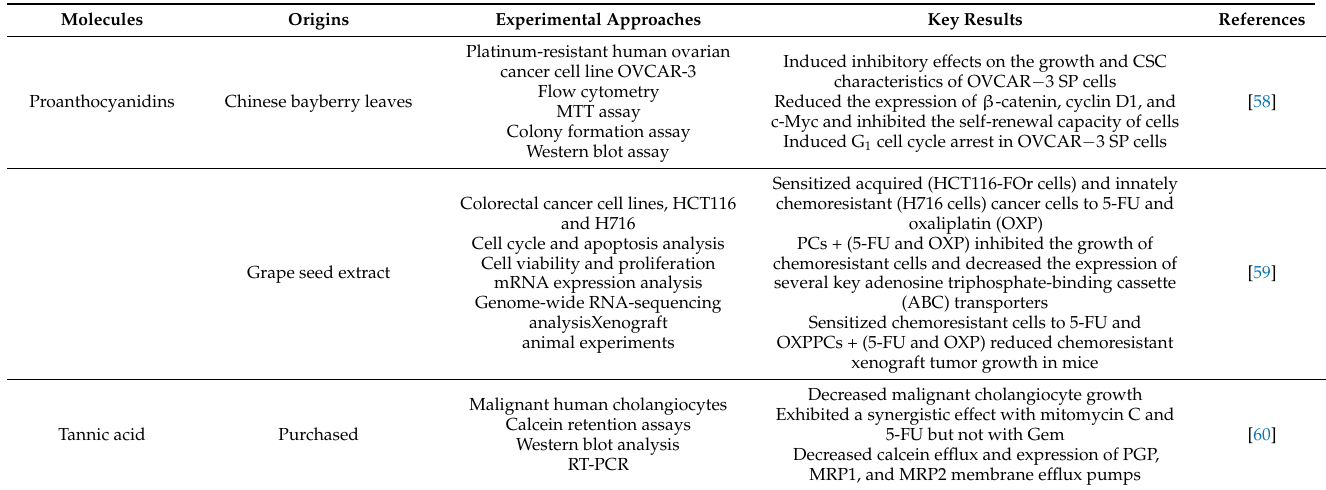
Figure 6. Chemical structures of tannins that improve chemosensitivity of anticancer drugs. Table 4. Condensed tannins that could improve the chemosensitivity of cancer drugs.